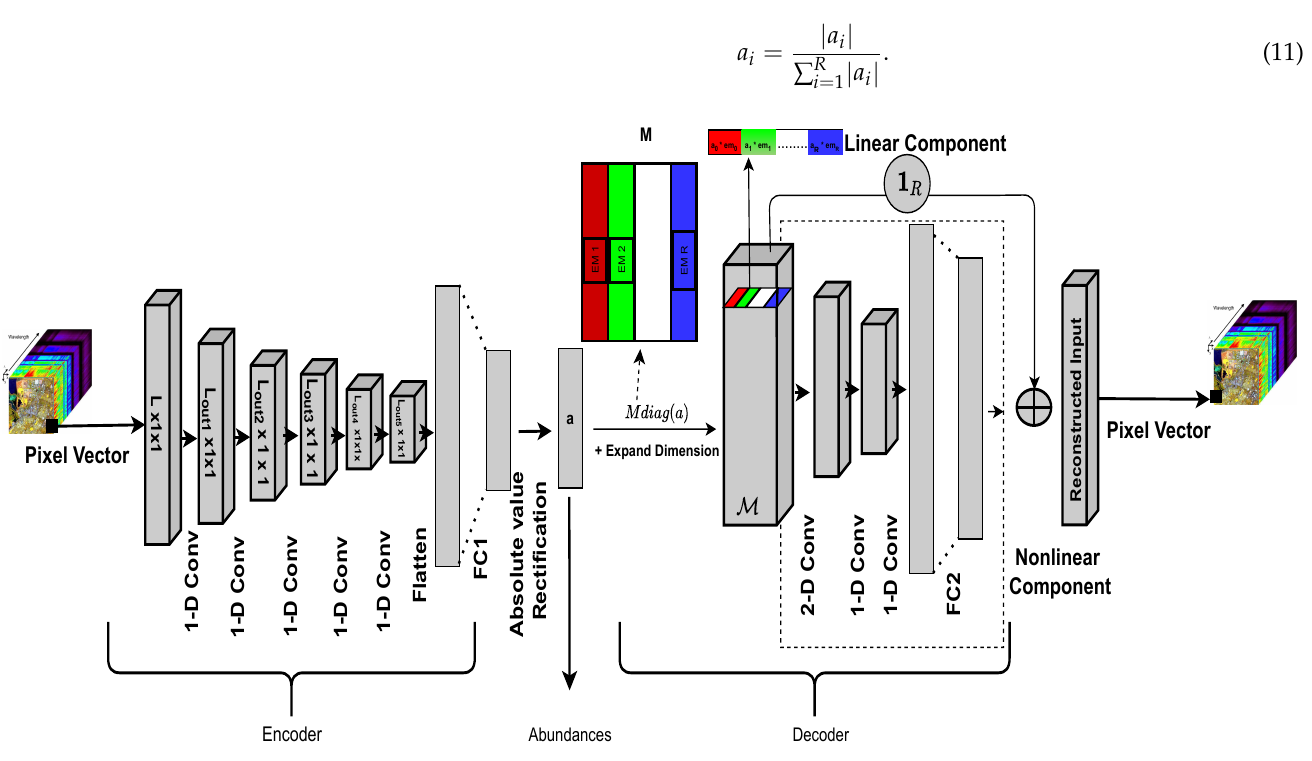
Figure 3. Diagram of the proposed system. Table 1. Architecture of the proposed